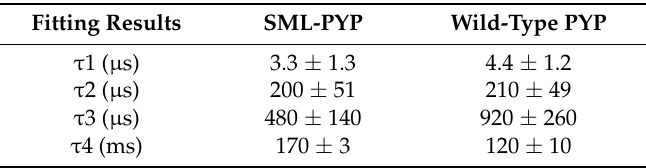
Figure 2. ( a ) Transient Absorption (TA) spectra of SML-PYP (red) are compared with those of wild-type PYP (black). Time delays for the TA spectra are (from top to bottom): 100 ns, 1 µ s, 10 µ s, 100 µ s, 1 ms, and 10 ms. ∆ O.D. stands for the optical density change and the spectra are vertically offset for clear presentation. ( b , c ) Temporal profiles of TA signal for ( b ) SML-PYP and ( c ) wild-type PYP measured at the probe wavelengths of 380 (red), 465 (green), and 494 nm (blue) are shown. The decay profiles of each protein were globally fit by the sum of exponential functions consisting of four exponentials and an offset. The fit lines are shown in black dotted lines. The time constants determined by the fit are listed in Table 1. ( d , e ) Schematic illustrations of ( d ) the sequential kinetic model and ( e ) the parallel kinetic model for the photocycle of PYP. h ν indicates the optical excitation. Table 1. Time constants of SML-PYP and wild-type PYP determined by the fitting of TA data.